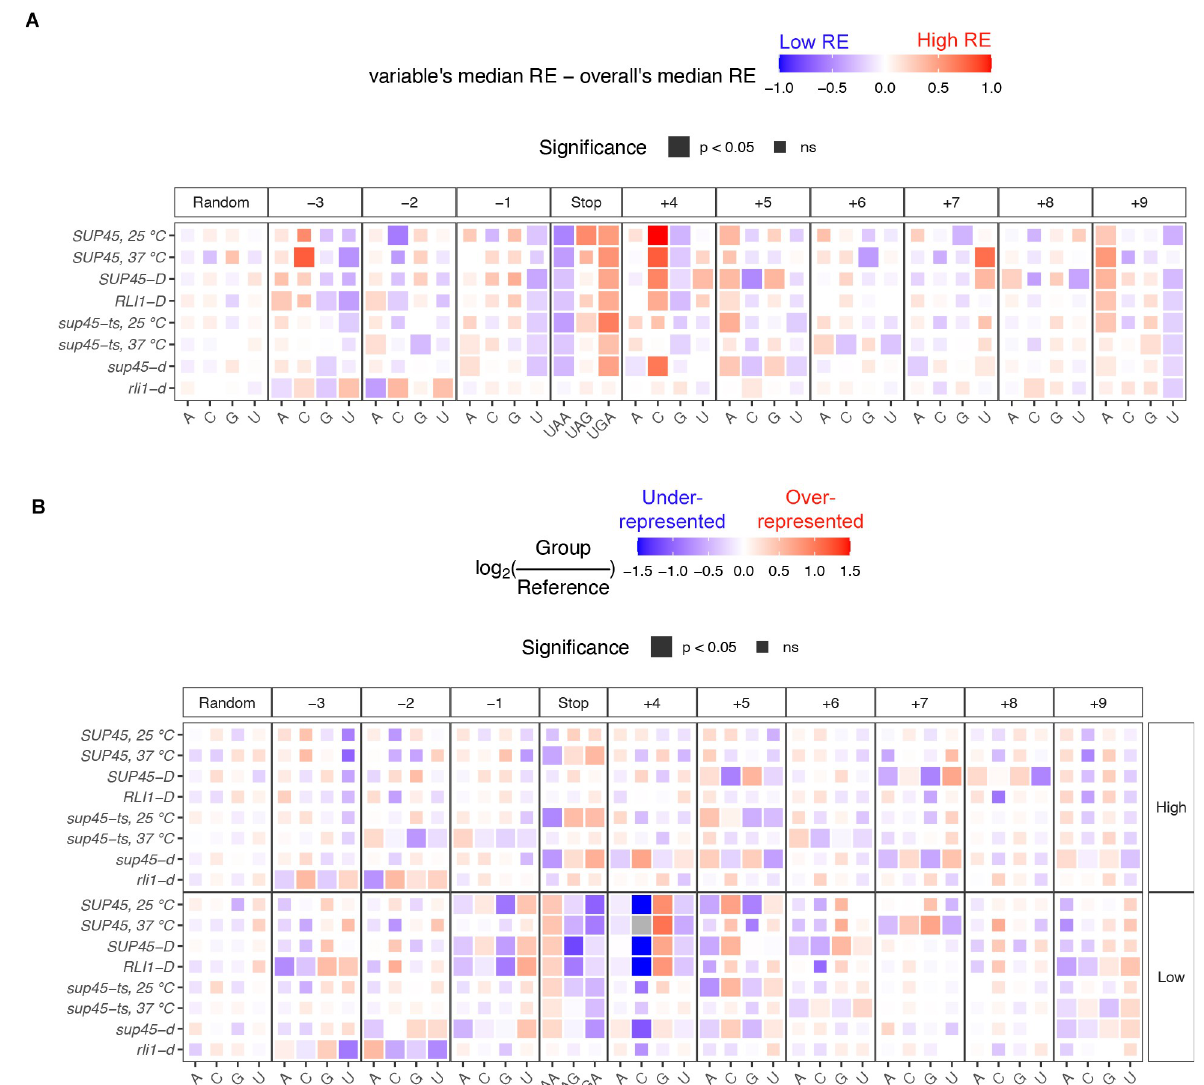
Fig 5. Known individual effects of stop codon and surrounding nucleotide identities on readthrough efficiency occur at a genome-wide level. A. Heatmap of median readthrough efficiency of genes containing particular stop codon or nucleotide relative to median readthrough efficiency of all genes in the sample. Positive value (red) indicates that the group of genes had higher readthrough efficiencies compared to the sample median, while negative value (blue) indicates lower readthrough efficiencies. Wilcoxon’s rank sum test was used to determine whether the difference in group and sample media was significant. Significant difference was represented as a larger tile. B. Heatmap demonstrating over-representation (red) or under-representation (blue) of a stop codon or nucleotide in “High” or “Low” readthrough groups relative to the frequency in the reference gene set. χ 2 goodness of fit test with Bonferroni correction was performed to compare usage distribution between the “High” readthrough group, “Low” readthrough group, and the reference. Significant difference was represented as a larger tile. Grey tiles signify that there was zero observation of that nucleotide (essentially under-represented), and log 2 calculation and statistical analysis could not be performed.